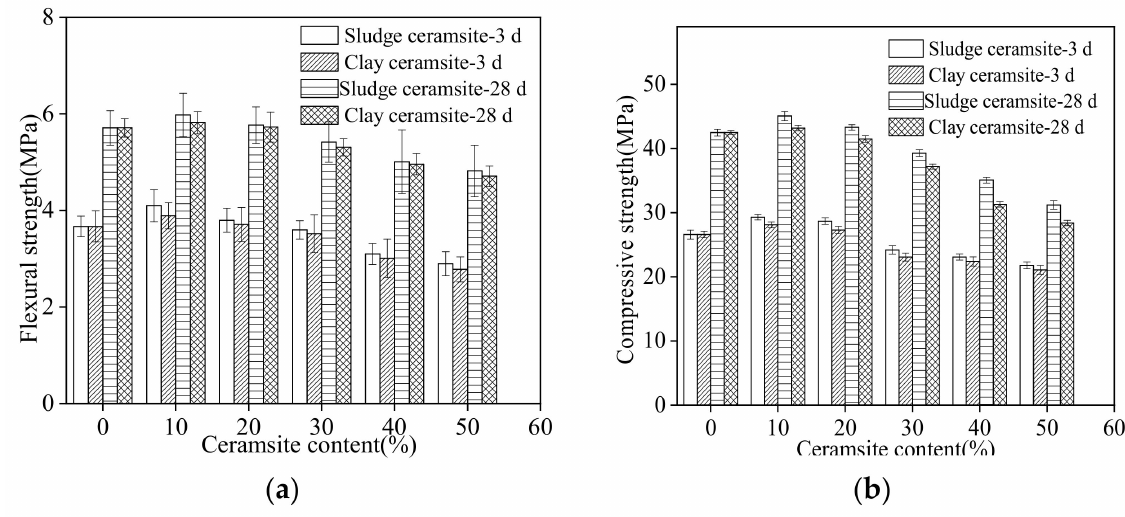
Figure 7. Mechanical strength of ceramsite cement concrete at different curing times. ( a ) Flexural strength. ( b ) Compressive